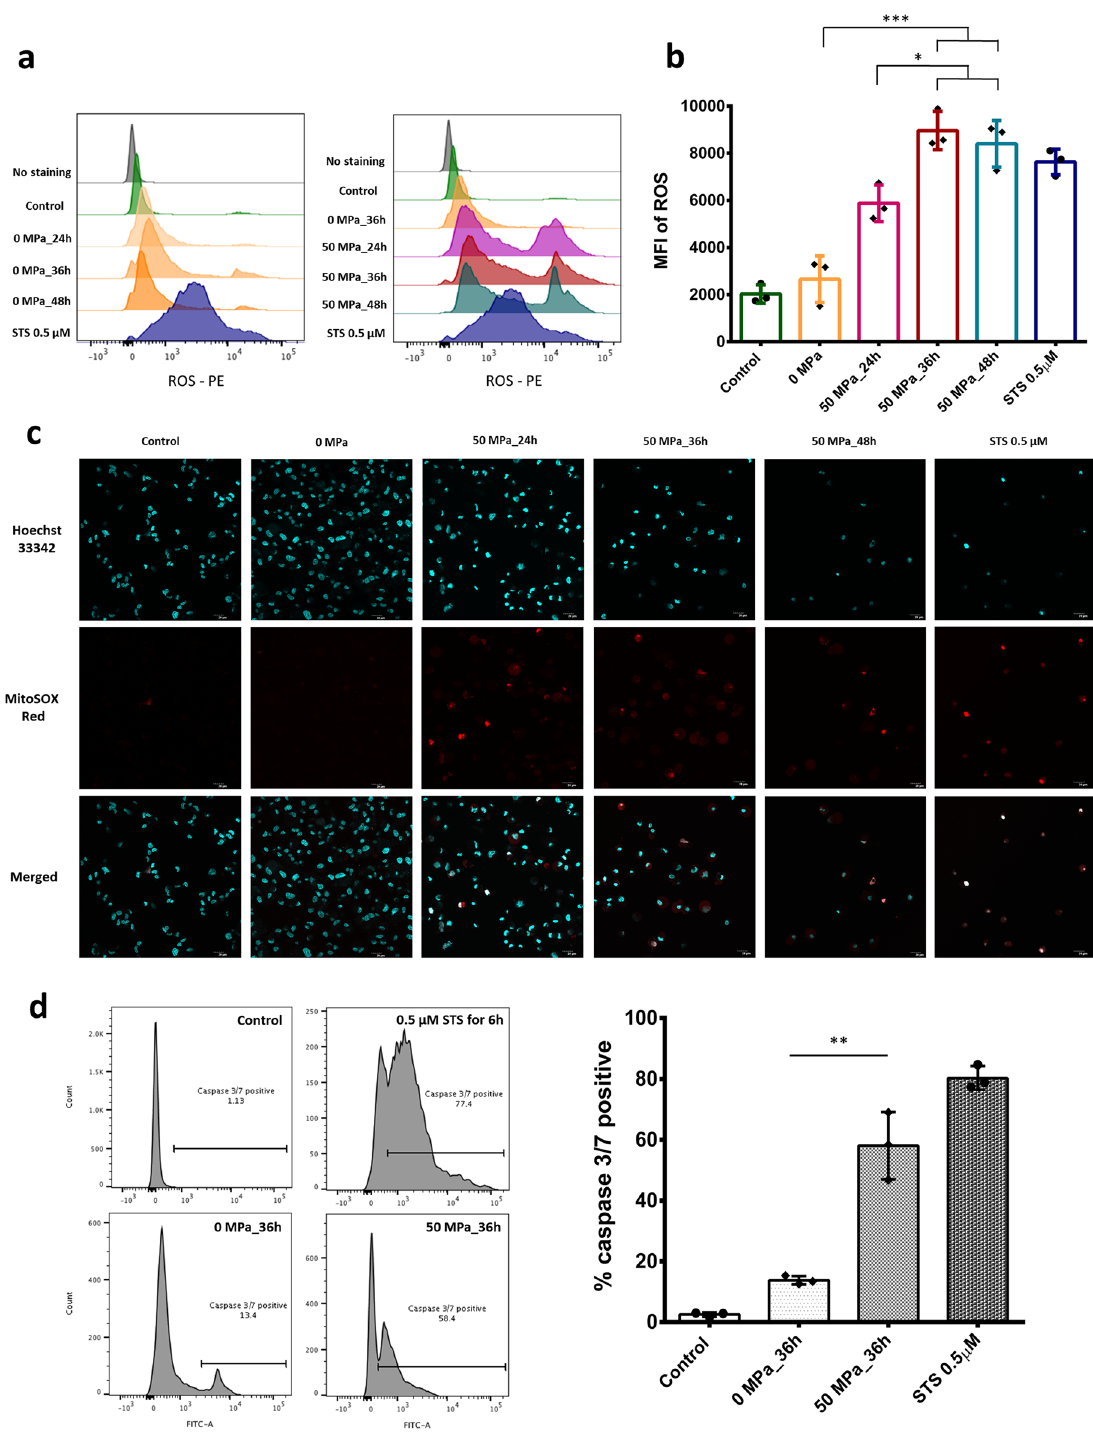
Figure 4 . Reactive oxygen species (ROS) generation and activated caspase 3/7 in response to HHP treatment. ( a ) Left: representative histograms of the fluorescence expression of MitoSOX Red among the control, STS- treated and various time exposure of 0 MPa groups. Right: representative histograms of the fluorescence expression of MitoSOX Red among the control, STS-treated and HHP-exposed and unexposed groups. ( b ) Diagram comparing the MFI of ROS elevation among groups (n = 3). ( c ) Immunofluorescence images of ROS production stained by MitoSOX Red mitochondria indicator and Hoechst 33,342 showing the generation of a ROS signal after 50-MPa treatment for 24, 36 or 48 h. Scale bar: 20 μm. Data are representative of at least three independent experiments. ( d ) Activated caspase 3/7 fluorescence expression and ratio of caspase positivity between groups without HHP (0 MPa) and with 50 MPa for 36 h (n =